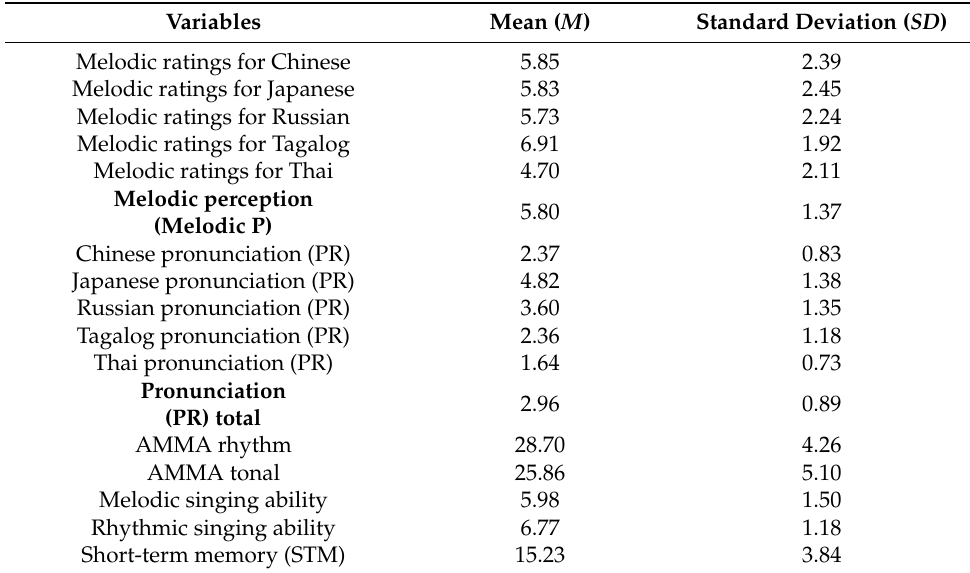
Table 2. Descriptives of the variables of this investigation.